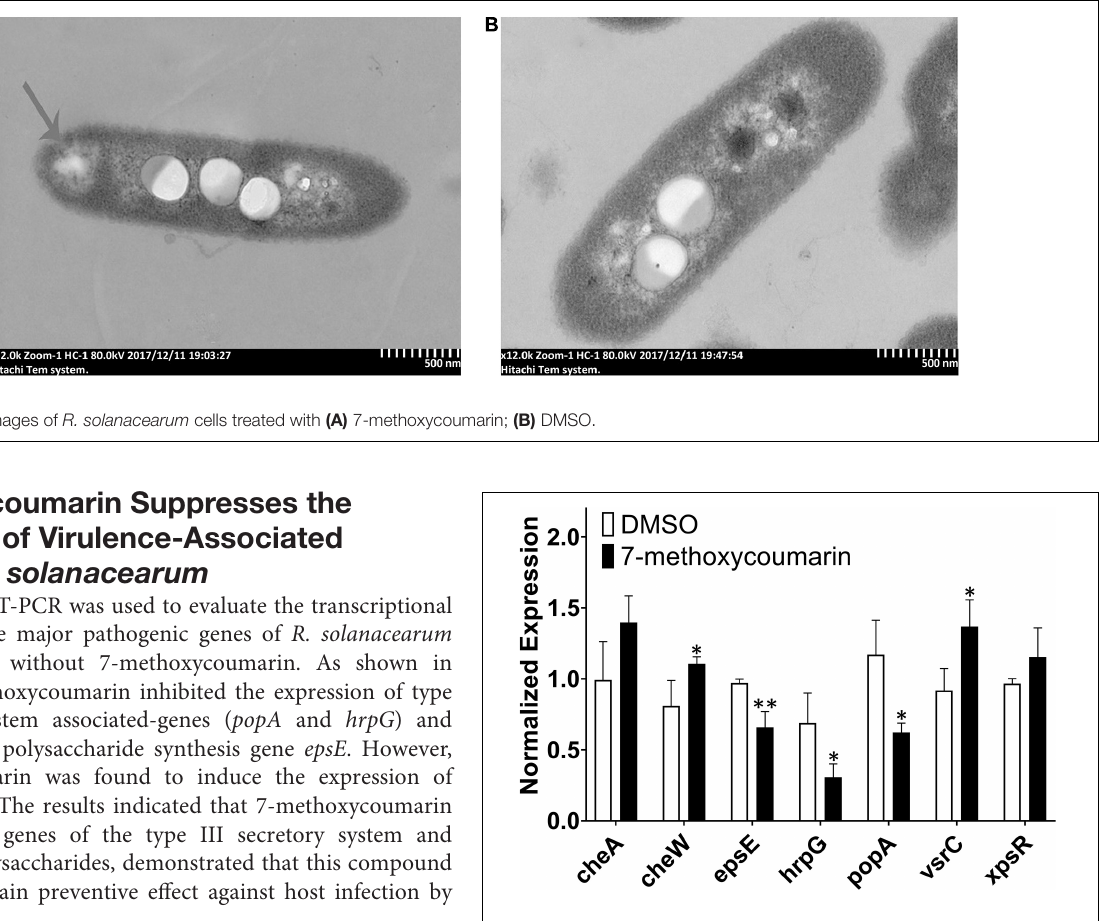
FIGURE 6 | The expression of some virulence-associated genes of R. solanacearum was quantified by qRT-PCR after treatment with or without 7-methoxycoumarin (* indicates p < 0.05 and ** indicates p < 0.01).